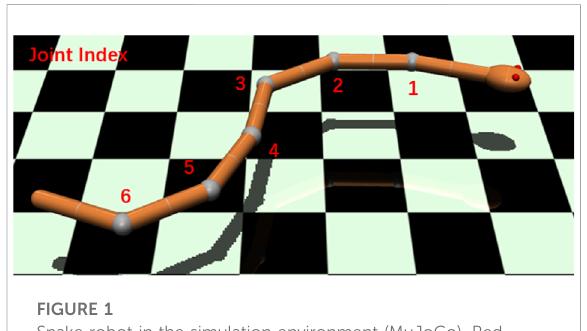
FIGURE 1 Snake robot in the simulation environment (MuJoCo). Red numbers show the joint